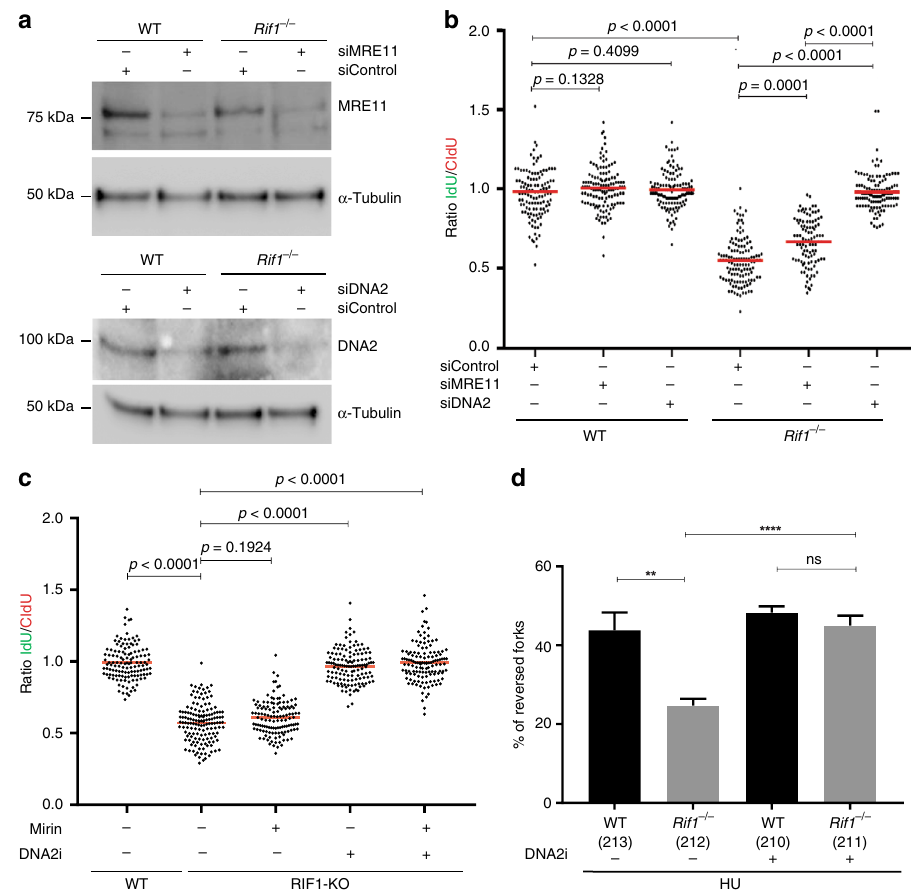
Fig. 3 DNA2 drives reversed fork degradation in RIF1-de fi cient cells. a Western blot analysis for the downregulation of MRE11 and DNA2 in WT and Rif1 − / − MEFs. WT and Rif1 − / − MEfs were transfected with either siControl or siRNAs smart pool against MRE11 and DNA2. Lysates made were probed with antibody against MRE11 and DNA2. Tubulin is used as loading control. b Ratio of IdU versus CldU in WT and Rif1 − / − MEFs upon HU treatment after downregulating Mre11 or DNA2 ( a ). c Ratio of IdU versus CldU in WT and RIF1-KO HAP1 cells upon HU treatment after inhibiting Mre11 and DNA2 using mirin and DNA2 inhibitor. d Electron microscopic analysis of percentage of reversed forks observed in WT and Rif1 − / − MEFs subjected to HU (4 mM) for 3 h, with or without DNA2 inhibitor. Numbers of analyzed molecules are indicated in parentheses. At least 125 readings were taken for b and c and the mean ratio is represented by red bar. P -values were derived from Kruskal – Wallis ANOVA with Benjamini Hochberg post test except in d , where unpaired t -test (ns, non-signi fi cant, **** P < 0.0001, ** P = 0.0024) was carried out. Similar observation was made from three independent experiments (Supplementary Data 2 and Supplementary Fig. 7g,